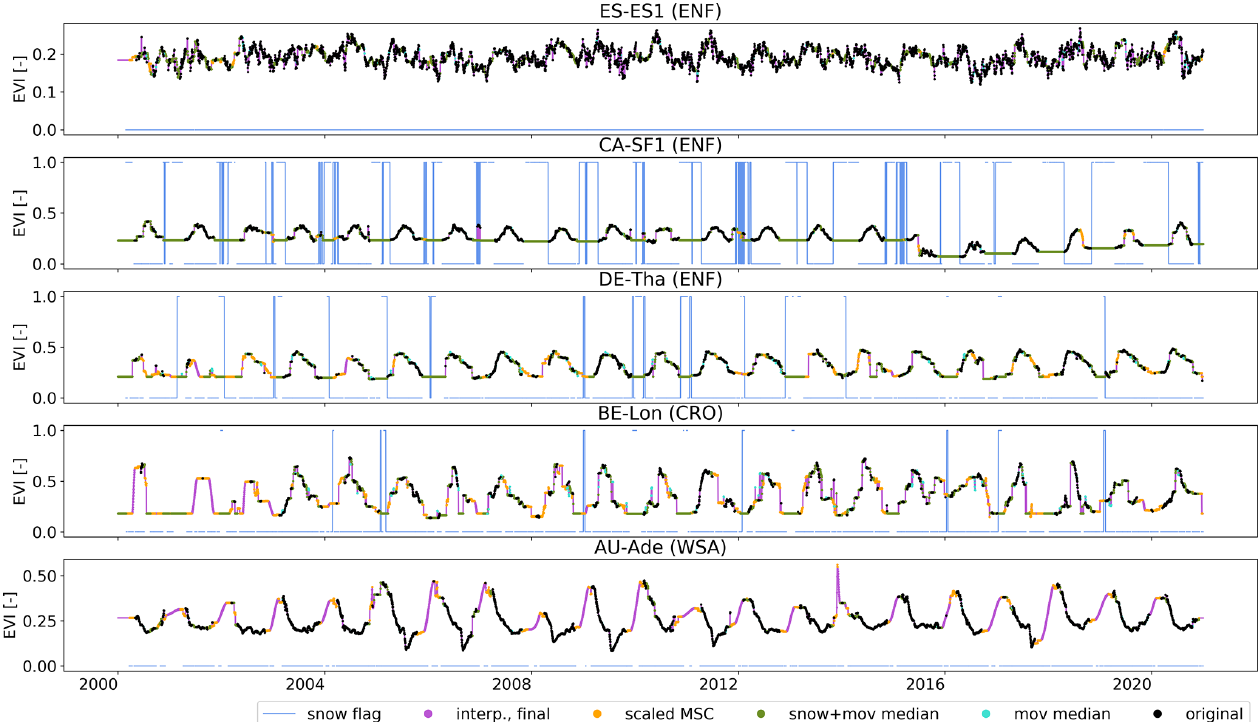
Figure 4. Illustration of gap-filling steps in the 500m pixel containing selected eddy-covariance sites for the MODIS EVI.